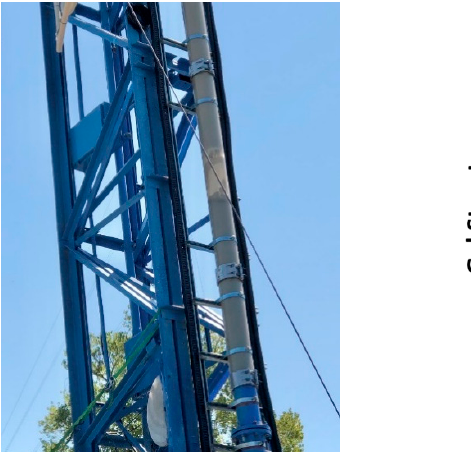
slight decrease in drift velocity can be observed in 45 lb/bbl bentonite at 4° as the bubble